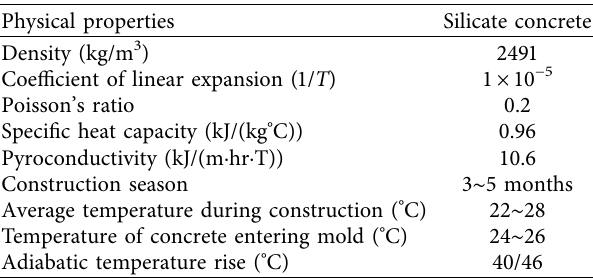
Table 2: Summary of calculation parameters of cap